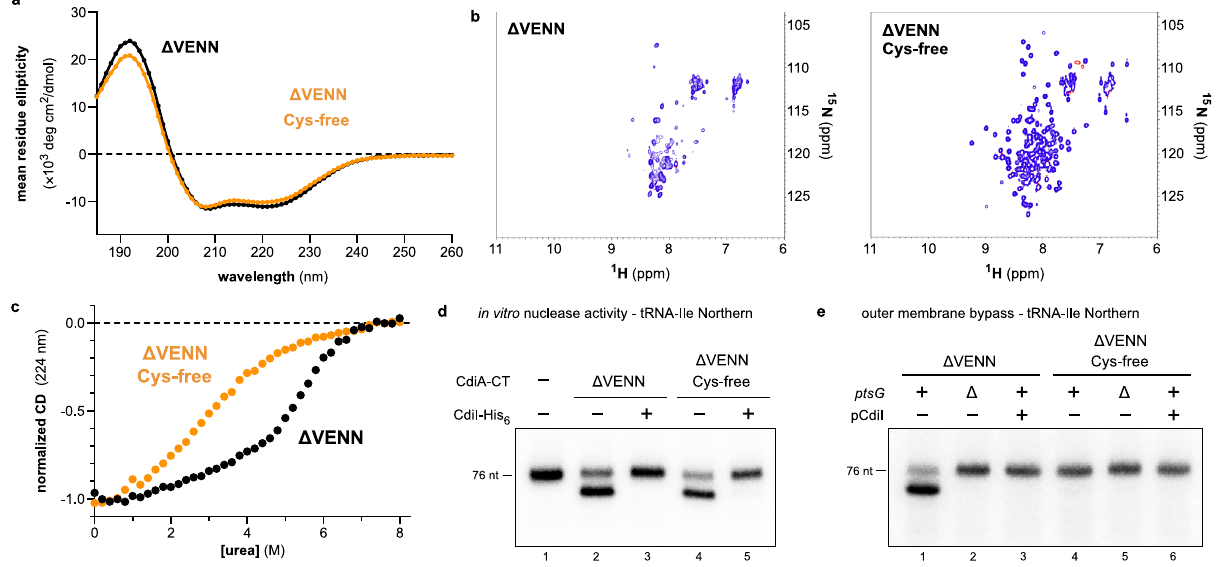
Fig. 6 | The entry domain is stabilized by a conserved disul fi de that promotes translocation. a CD spectraof wild-typeand Cys-free Δ VENNentrydomains. b 1 H- 15 NHSQCNMRspectraofwild-typeandCys-free Δ VENNentrydomains. c Chemical denaturation of wild-type and Cys-free Δ VENN entry domains. d In vitro nuclease activity. E.coli totalRNAwastreatedwithCdiA-CT EC3006 proteinsintheabsenceand presenceofpuri fi edCdiI EC3006 immunityprotein(CdiI-His 6 ). e Puri fi edCdiA-CT EC3006